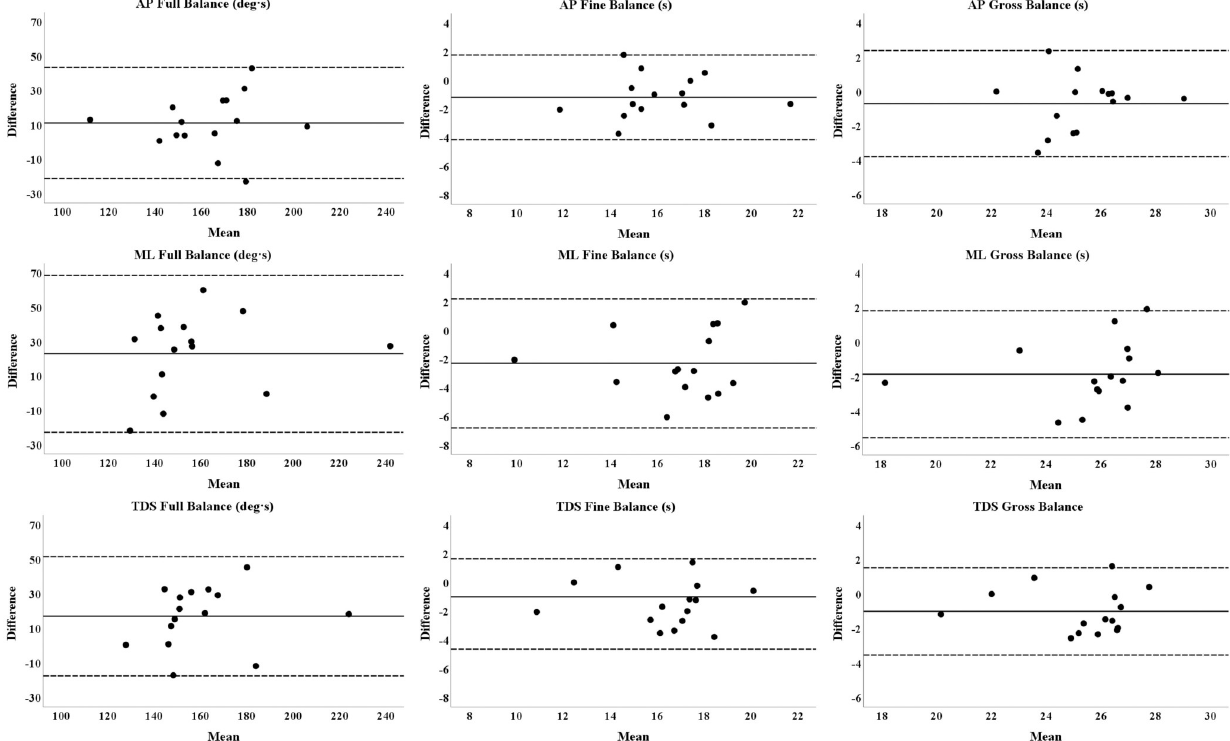
Fig 3. Bland-Altman plot for Full Balance, Gross Balance, and Fine Balance parameters in the anterior-posterior, medio-lateral, and TDS conditions. Differences between test and retest scores are plotted against their means. The black line indicates the average of the differences, whereas the dotted ones represent the 95% limits of